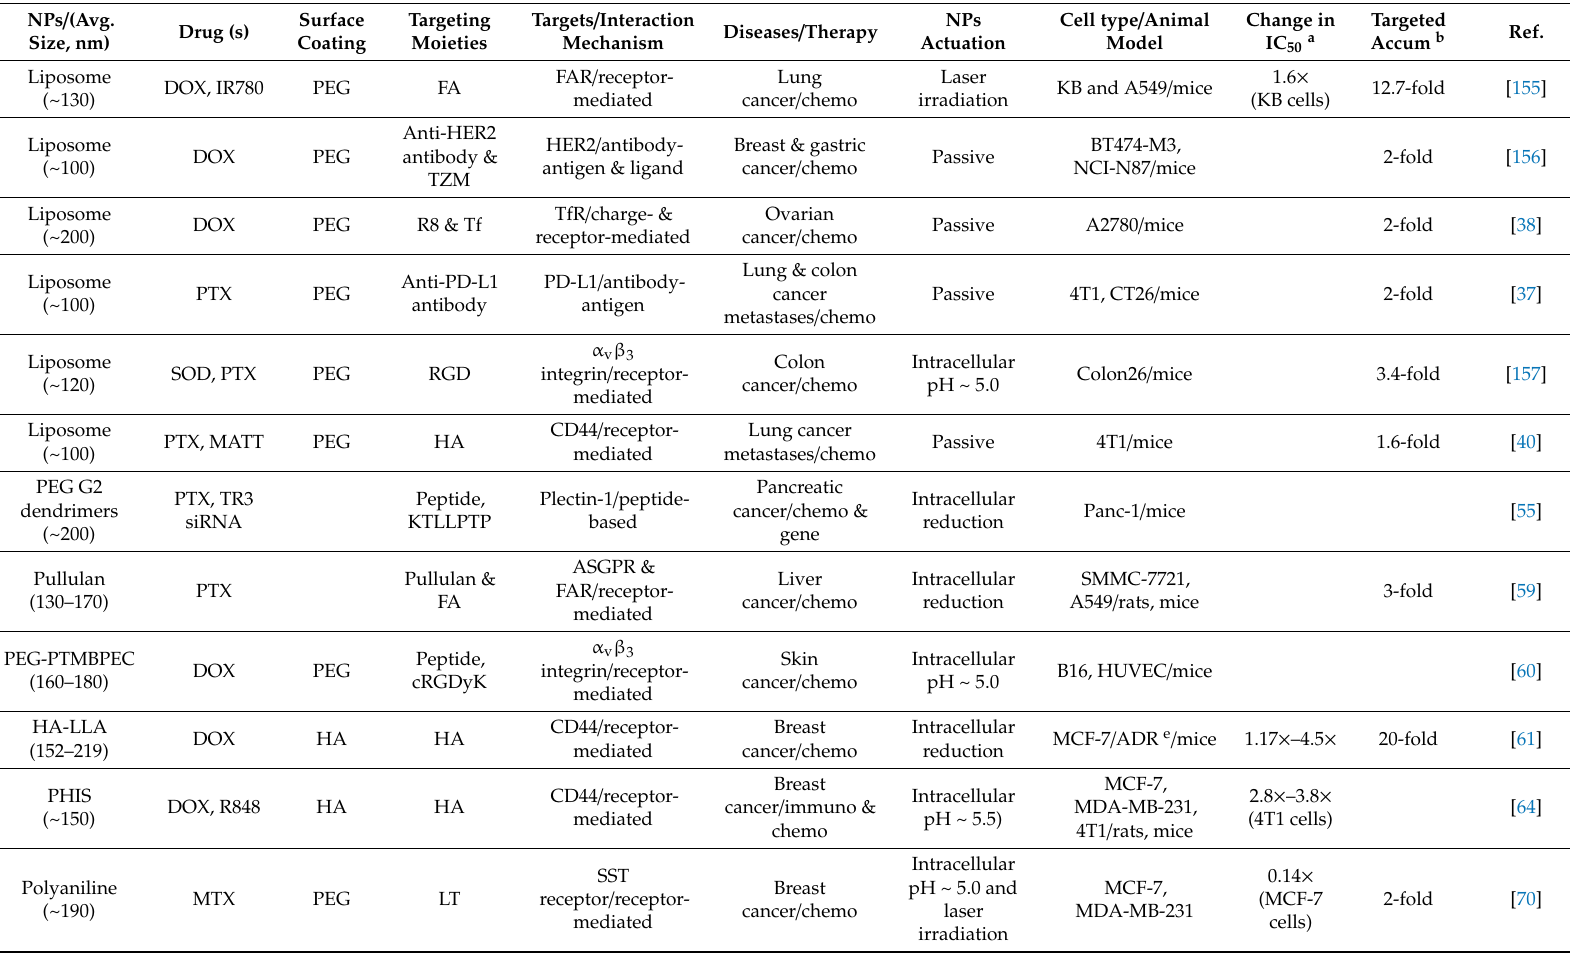
Table A1. Select examples of nanoparticle (NP) formulations for cellular / tissue targeted drug